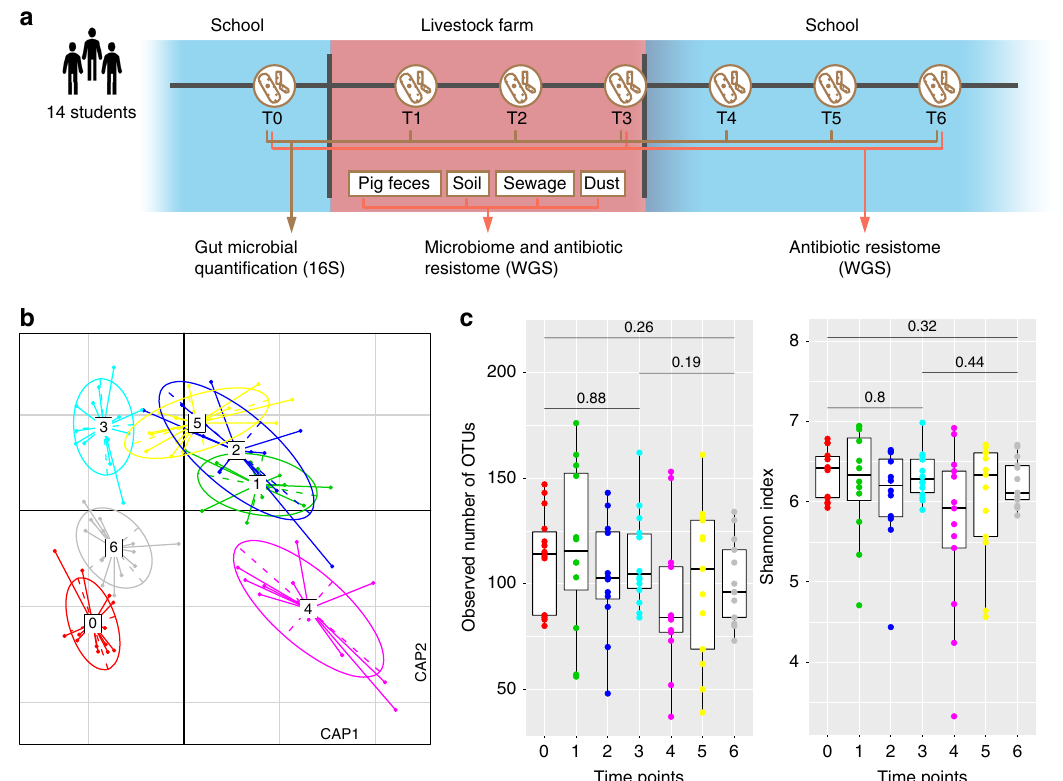
Fig. 1 Change in the human gut microbiota following environmental conversion. a Overview of the study design. Fourteen veterinary students ’ fecal samples were collected at seven time points: T0, 1 – 2 weeks before work on the swine farm; T1 – T3, while living and working at the swine farm; T4 – T6, after returning to the university. b Distance-based redundancy analysis (dbRDA) revealed gut microbiota dysbiosis during the students ’ swine farm stays, which partially recovered after leaving the farm. dbRDA of Bray – Curtis distances between operational taxonomic units (OTUs, based on 16S sequences) in samples at all-time points is shown at the fi rst two constrained principal coordinates (CAP1 1.8% variance explained, CAP2 1.3% variance explained). Lines connect samples from the same time point, and colored circles indicate the samples near the center of gravity for each time point. The results depicted here are cumulative of the samples from three swine farms. c Change in the within-sample microbial diversity (observed number of OTUs and Shannon diversity index) of samples at seven different time points. Boxes show the distribution of students ’ samples ( n = 14 biologically independent samples per timepoint) (boxes show medians/quartiles; error bars extend to the most extreme values within 1.5 interquartile ranges). P > 0.05 by Student ’ s t -tests (paired two-sided test between the students ’ samples at time points 0, 3, and 6). P -values are multiple hypothesis test corrected using Benjamini – Hochberg (FDR) correction. Underlying data are provided in the Source Data fi